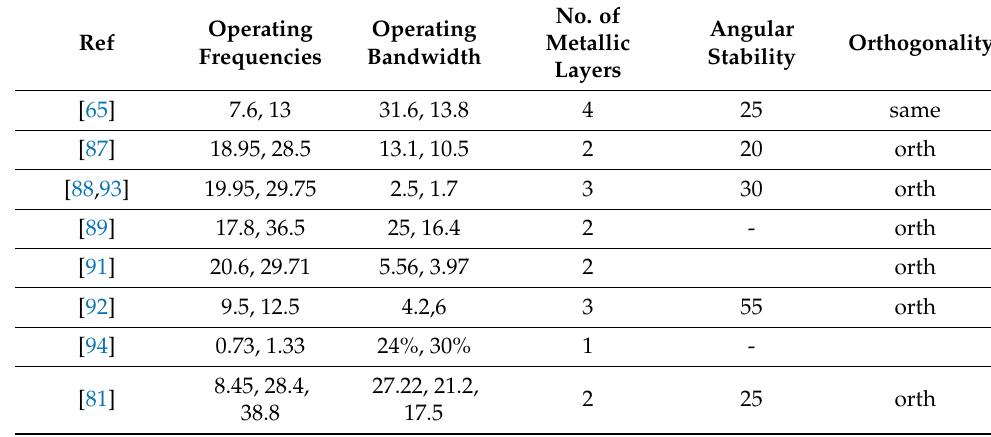
Table 2. State-of-the-art transmission-based multiband MS-based LP-to-CP converters.